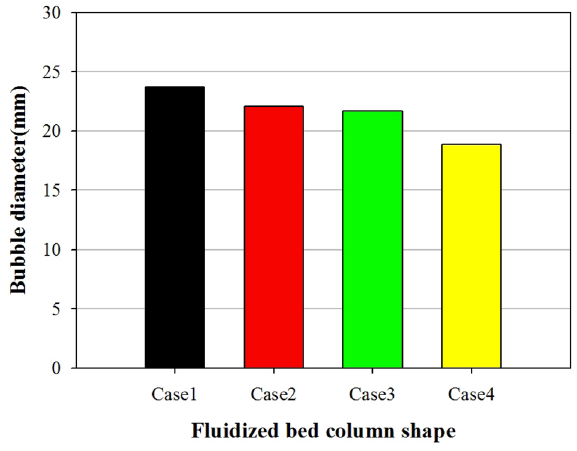
Figure 9. Bubble diameter for different shapes of fluidized bed